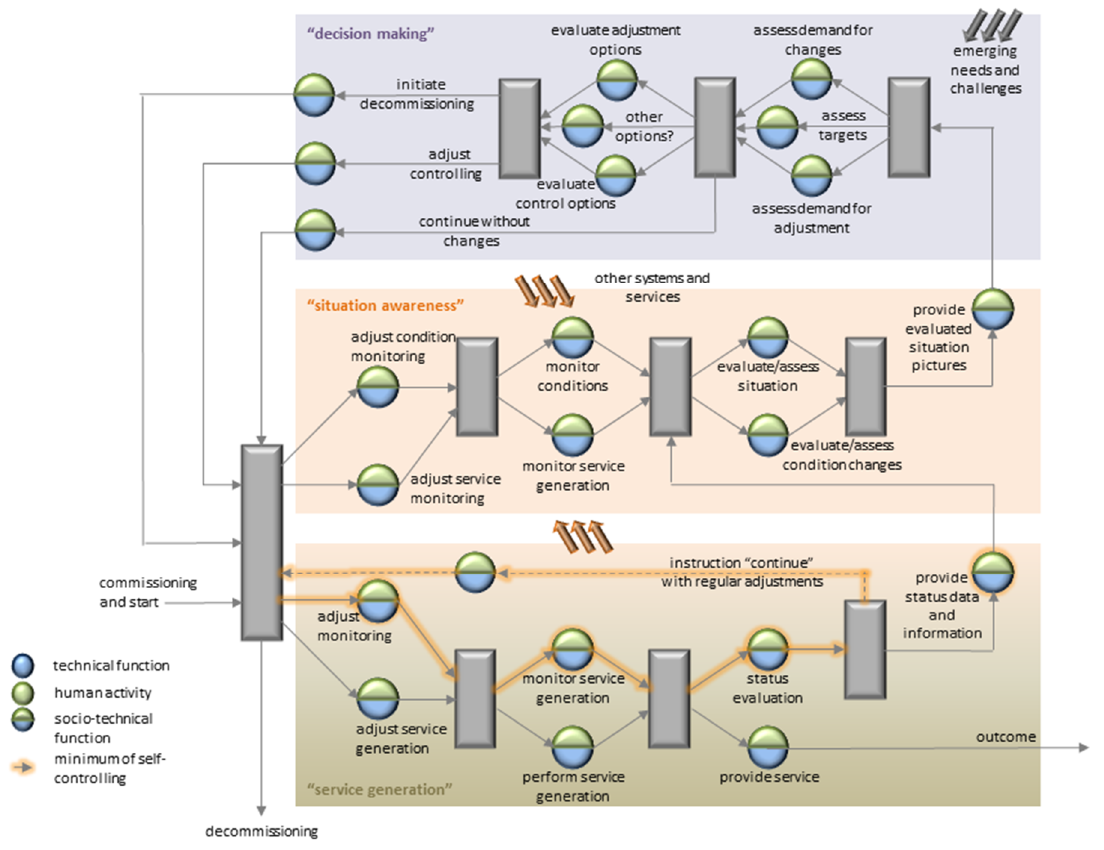
Figure 3. Simplified system model functionalizing situation awareness and decisions about situation- based adjustment processes.